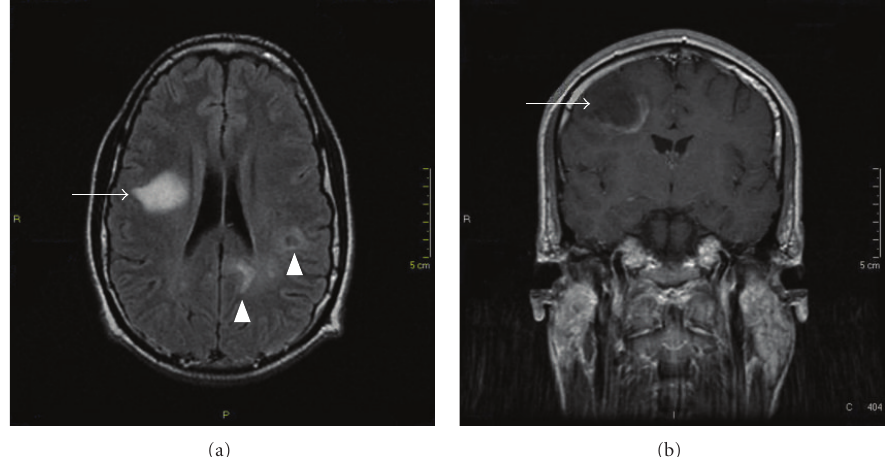
Figure 2: MRI scan after initial therapy. After two cycles of HD-MTX-based chemotherapy, the axial FLAIR image (a) shows good response of left brain masses (arrowheads) but progression of right frontal one (arrow) with contrast reinforcement on the T1-weigthed sequence with gadolinium